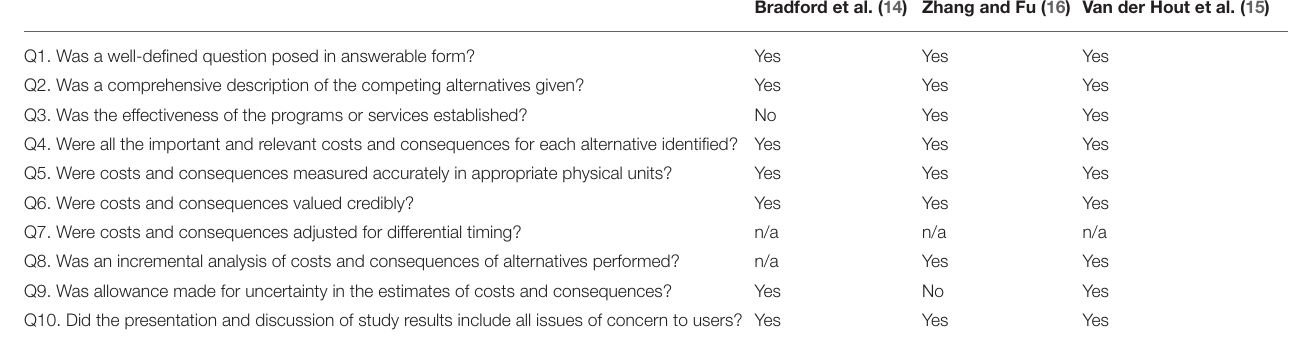
TABLE 3 | Methodological quality of included